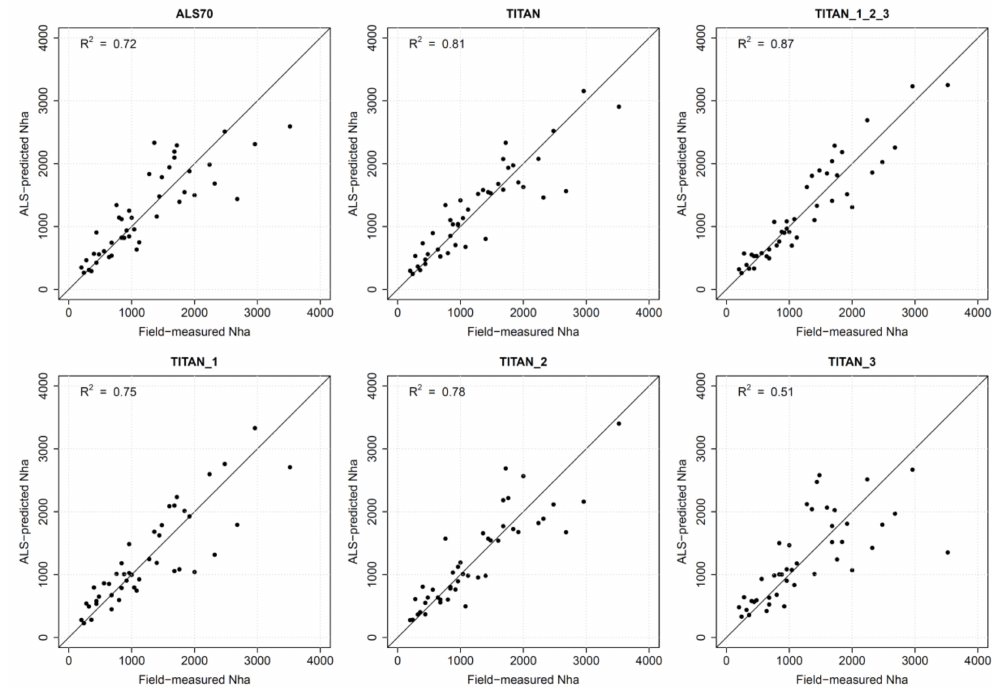
Figure 7. Scatterplots of the field-estimated and ALS-predicted values of the number of trees per hectare ( Nha ) for each sub-plot for each model. In each scatterplot the Pearson’s correlation coefficient between observed and predicted values is